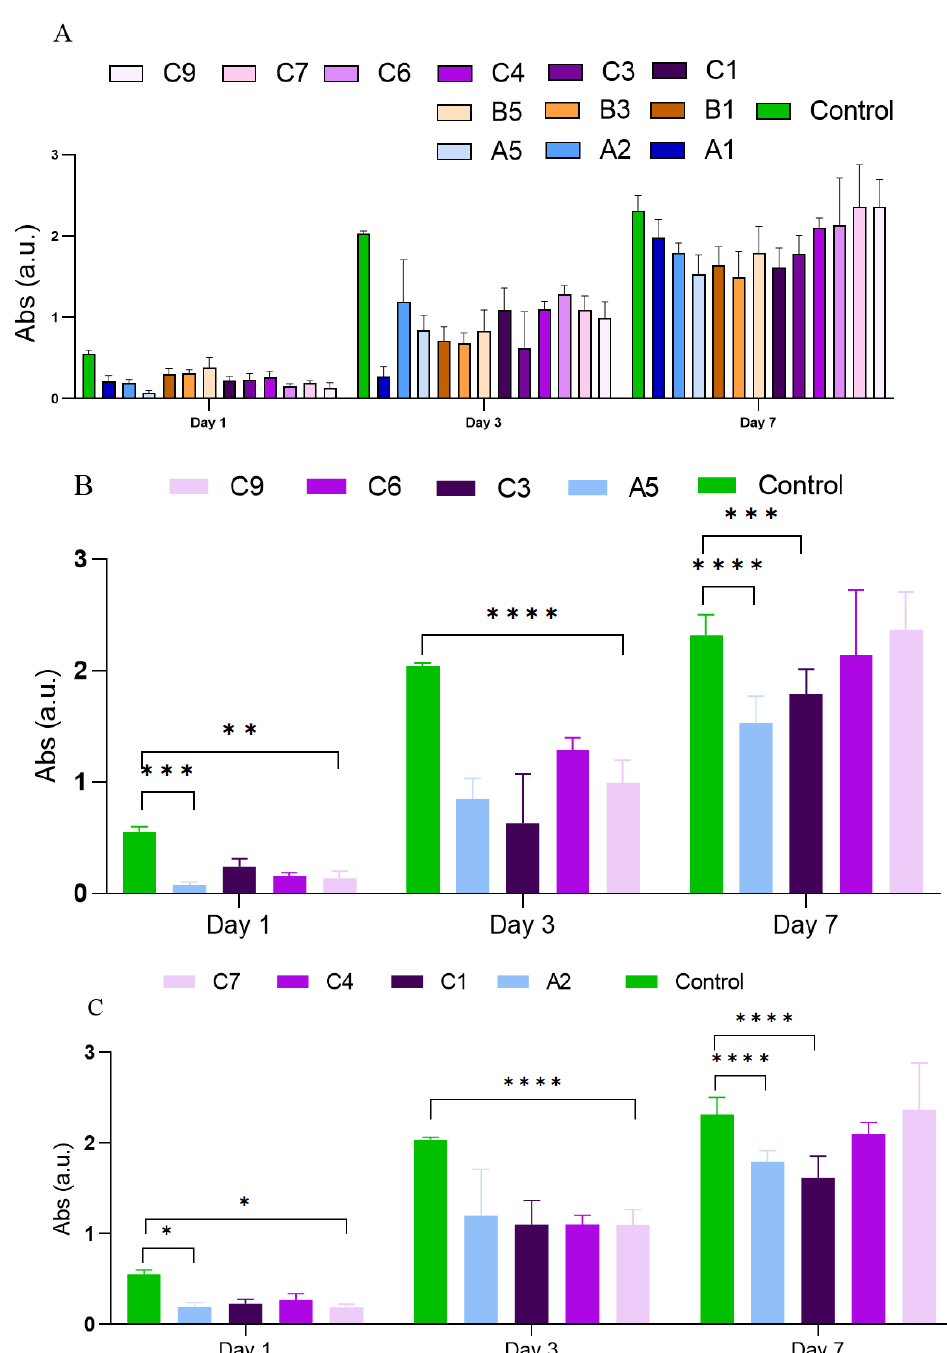
Figure 11. Comparative results of cell density between ( A ) SF/HA (A1, A2 and A5), curcumin- loaded SF (B1, B3 and B5), and curcumin-loaded SF/HA hydrogels (C1, C3, C4, C6 and C7; ( B ) SF/HA (A5) and curcumin-loaded SF/HA hydrogels (C3 C6, and C9)); ( C ) SF/HA (A2) and curcumin-loaded SF/HA hydrogels (C1 C4, and C7). Data are expressed as percentage of cell viability ± SD vs. concentration. * Indicates p < 0.05, ** indicates p < 0.01, *** indicates p < 0.001 and **** indicates p < 0.0001, compared to control.